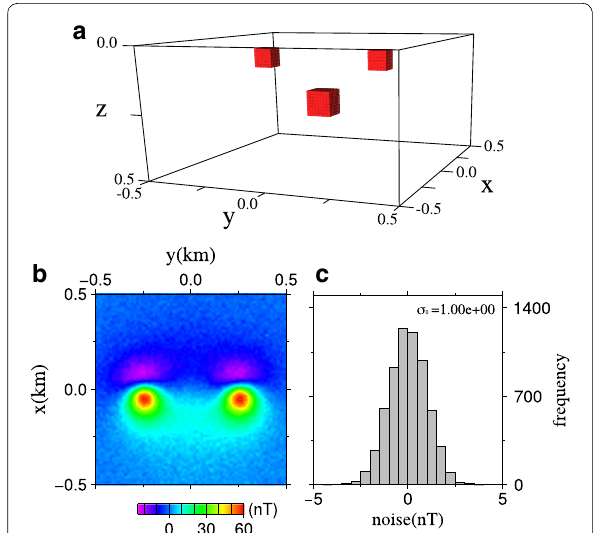
Fig. 2 A synthetic model which consists three magnetized blocks. a A perspective view of the synthetic model which displays the all non-zero model elements. The induced magnetization of each block is 2 A/m, and the directions of the ambient geomagnetic field 50 ◦ and D 7 ◦ . b The total field anomaly are assumed to be I = = − computed by this synthetic model which is contaminated by an uncorrelated Gaussian noise with zero mean and a standard deviation σ